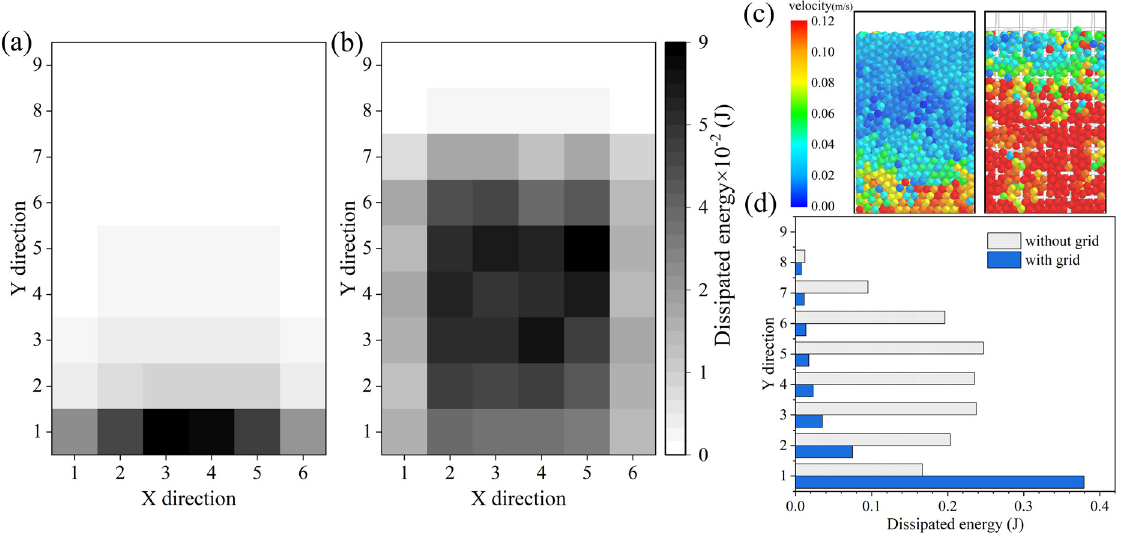
Figure 13. Energy dissipation distribution within the grid cell region of the particle damper, ( a ) without grid; ( b ) with grid; ( c ) velocity cloud of the particle damper with and without grid; ( d ) energy dissipation distribution in the Y-direction of the particle damper with and without grid.